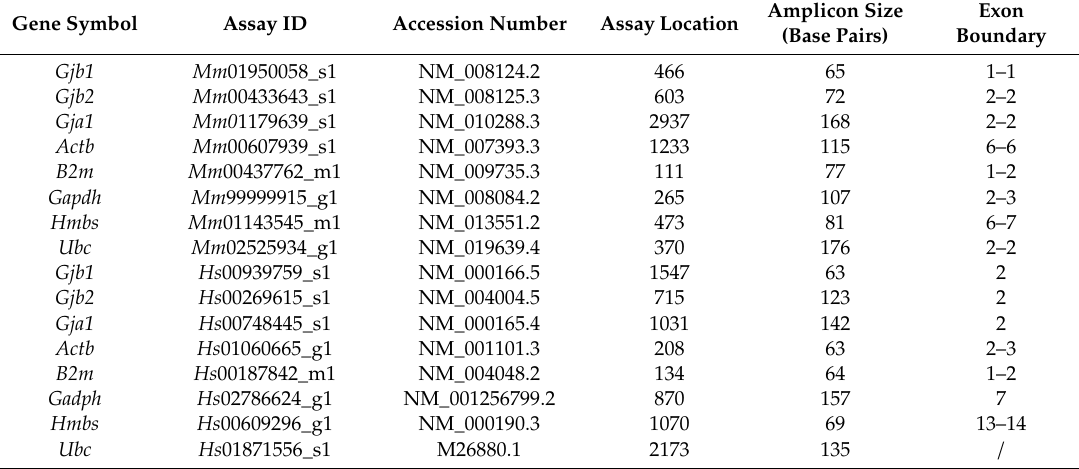
Table 1. Primers and probes used for RT-qPCR analysis of connexin and candidate reference genes. Assay identification (ID) for mouse (Mm; Mus musculus ) or human (Hs; Homo sapiens ) species, accession number, assay location, amplicon length and exon boundary of connexin and candidate reference genes are presented ( Gjb1 , Cx32; Gjb2 , Cx26; Gja1 , Cx43; Actb , β -actin; B2m , β -2-microglobulin; Gapdh